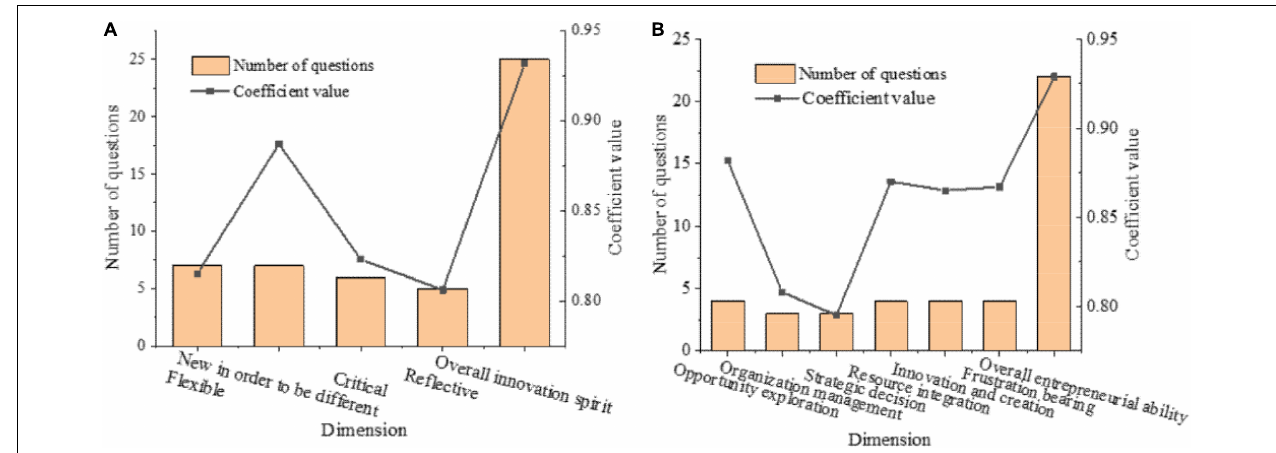
FIGURE 5 | Reliability test results ( A: reliability test of the College Students’ Entrepreneurial Spirit Scale ; B: reliability test of the College Students’ Entrepreneurial Ability Scale ).